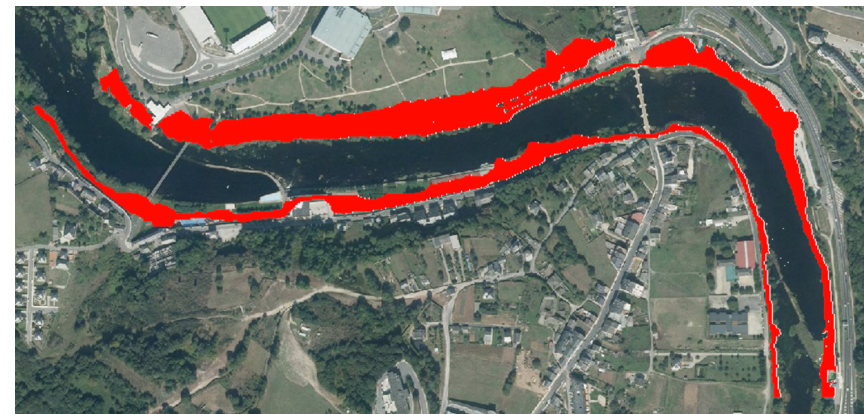
Figure 9. Areas where hazard criterion is surpassed (PNOA courtesy of © Instituto Geográfico